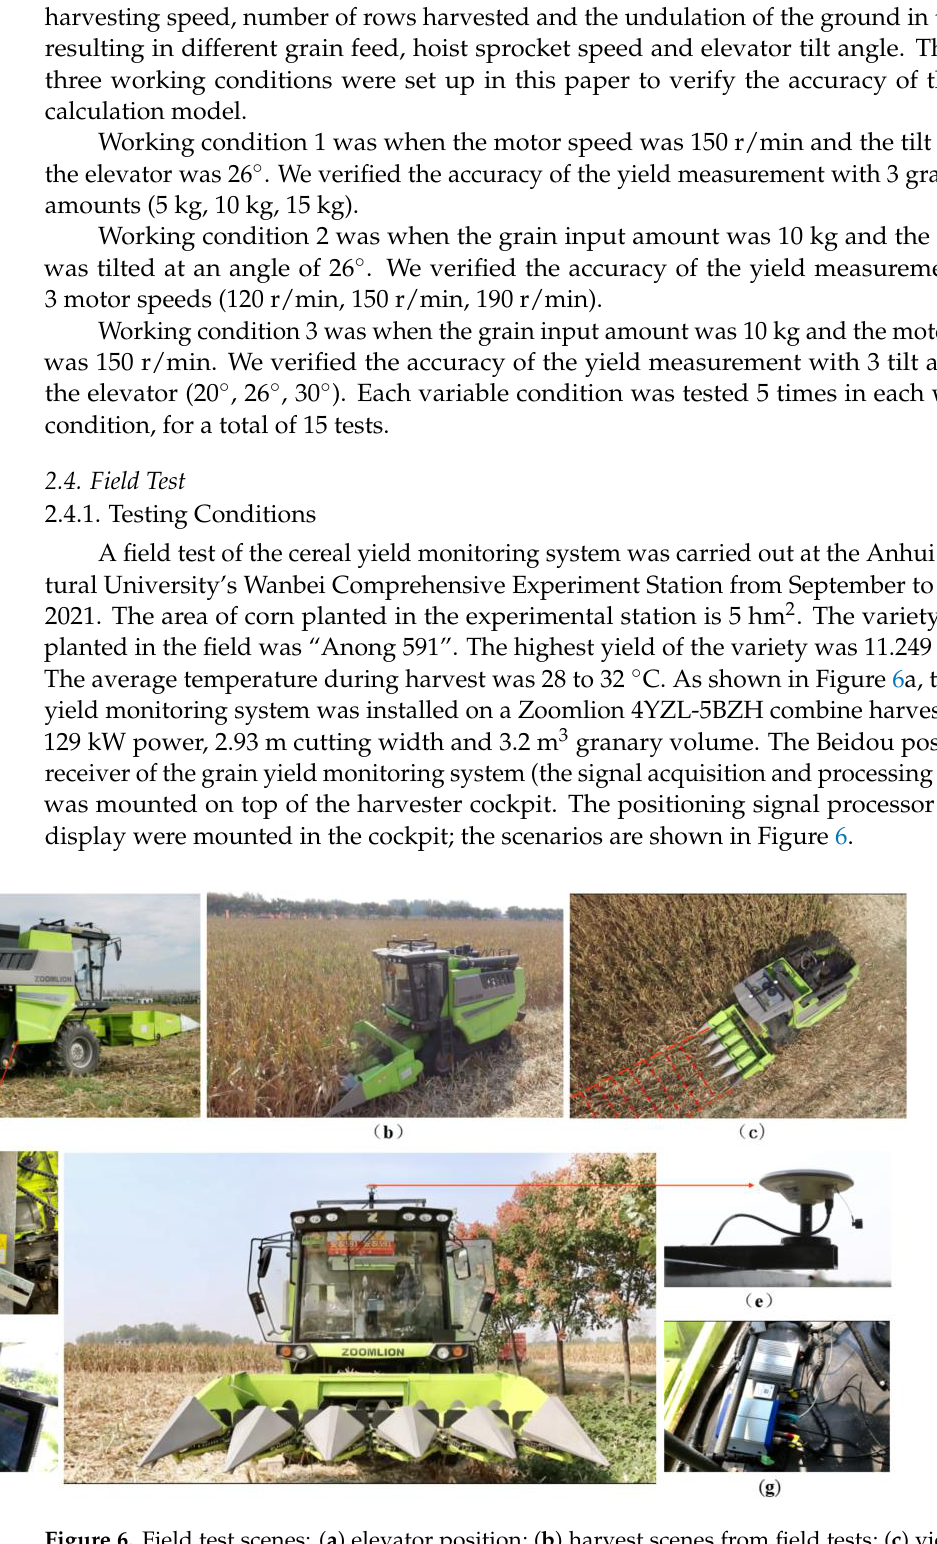
Figure 6. Field test scenes: ( a ) elevator position; ( b ) harvest scenes from field tests; ( c ) yield grids; ( d ) mounting position of the sensor; ( e ) BeiDou signal receiver; ( f ) display mounting position; ( g ) data processing side.